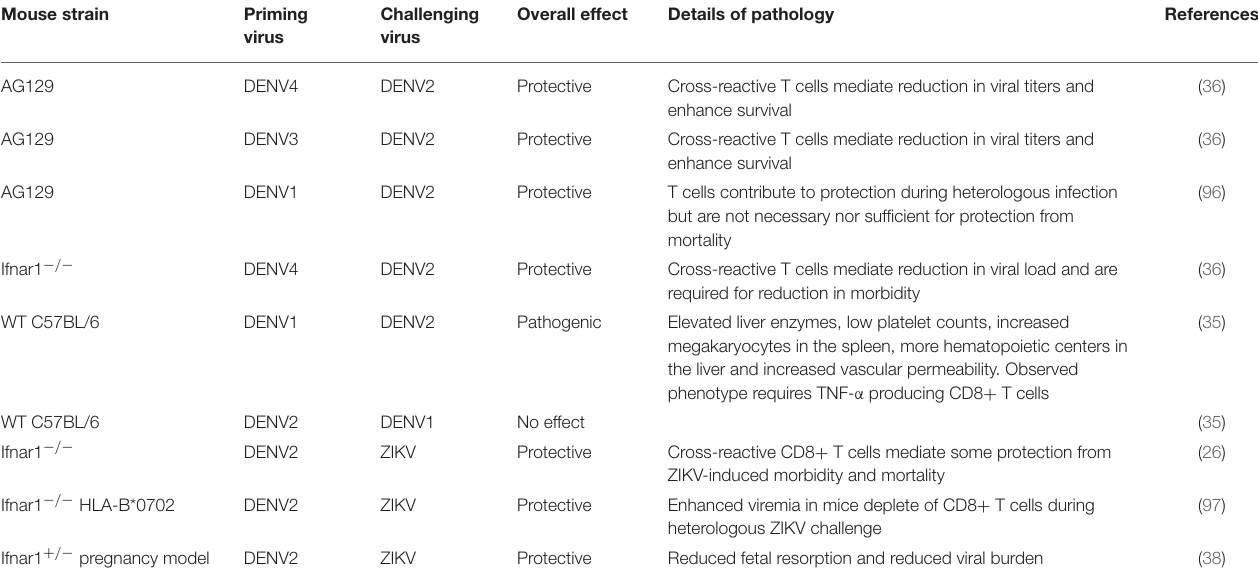
TABLE 1 | Select references for examples of the impact of flavivirus T cell cross-reactivity and murine models of pathogenesis. Mouse